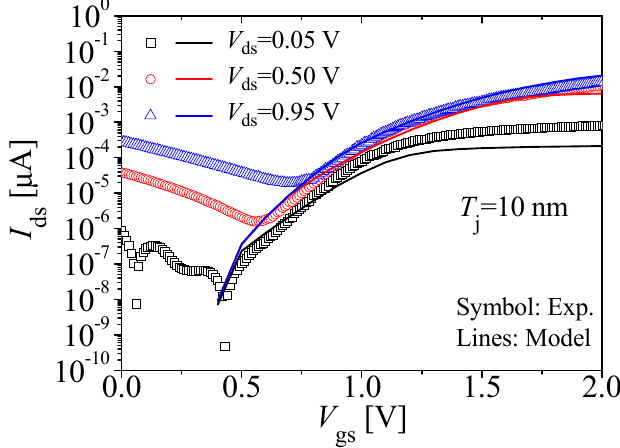
Figure 8. I ds from the experimental device (symbols) [12] compared with I ds_TAT calculated from (23).